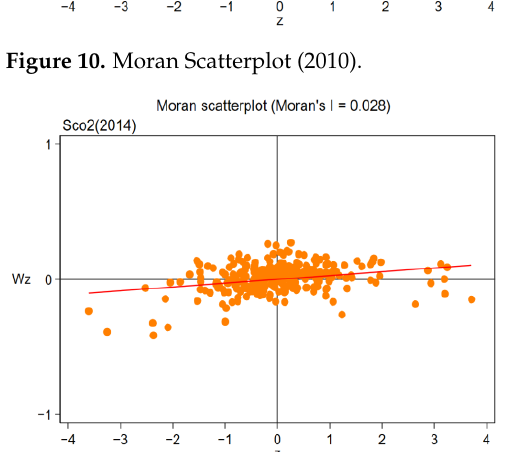
Figure 11. Moran Scatterplot (2014).